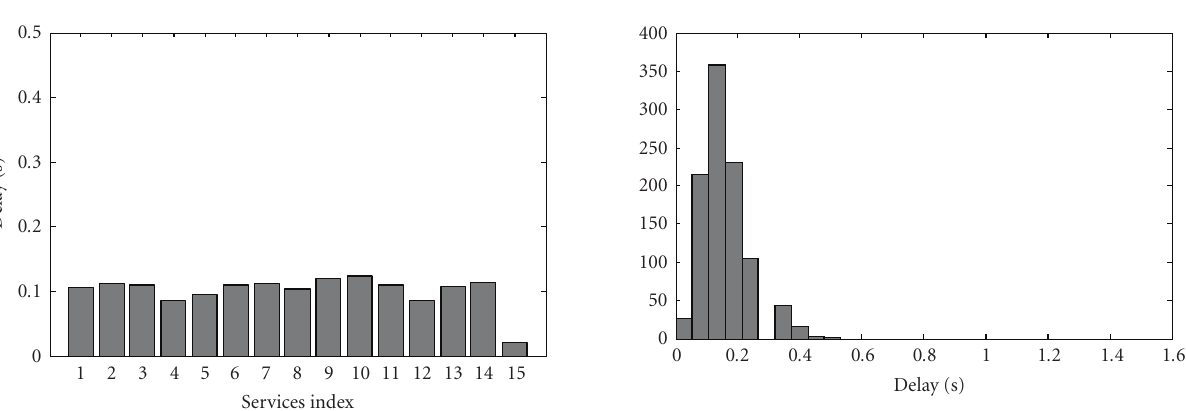
Figure 12: Bu ff ering delay in StatMux for the bit streams used in Figure 11.